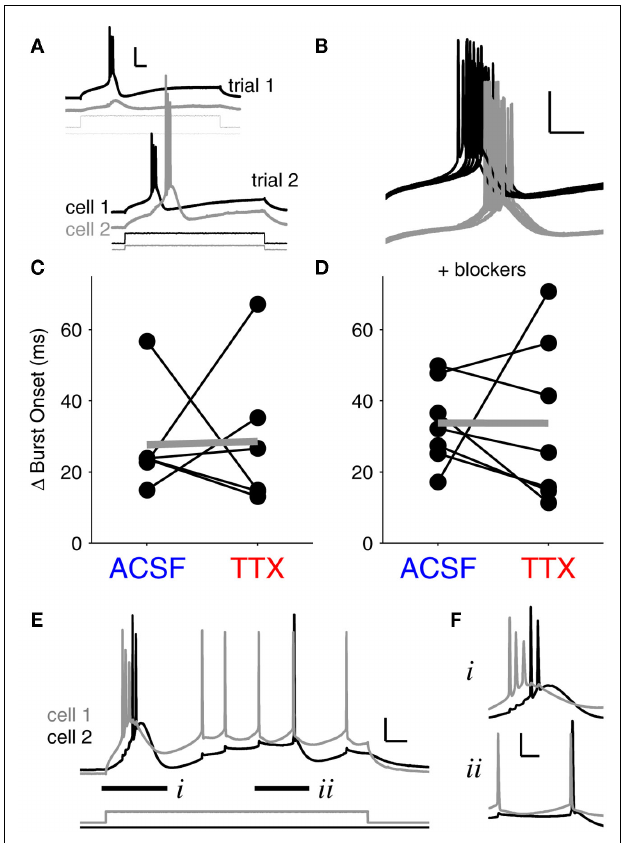
FIGURE 5 | Bursts are unsynchronized events. (A) Demonstration of the stimulation paradigm for paired burst firing. First, current thresholds for bursts were determined independently for each cell (trial 1). Next, bursts were elicited in coupled neurons by delivering peri-threshold current injections to both neurons simultaneously (trial 2).Traces are offset for clarity. Scale bar: 25mV, 50ms. Burst synchrony is taken as the absolute value of the difference in burst onset times between cell 1 and cell 2. (B) Finer time-scale of 15 burst trials in a pair of coupled neurons. Bursts rarely synchronized, and individual burst onsets also varied by tens of ms. Scale bars: 25mV, 50ms. (C) With spontaneous synaptic activity intact, burst synchrony did not show a significant change after blocking I NaP with 100nM TTX. Mean difference in burst onsets in ACSF: 27.6 ± 6.0ms (mean ± SEM, N = 6 pairs); mean difference in burst onsets inTTX: 28.6 ± 8.5ms ( p = 0.94, paired, two-tailed t -test). (D) In the presence of synaptic blockers (DNQX and APV), burst synchrony between coupled cells also showed no significant change afterTTX application. Mean difference in burst onset in ACSF: 33.7 ± 4.5ms ( N = 7 pairs); mean difference in burst onset inTTX: 33.6 ± 8.7ms ( p = 0.99, paired, two-tailed t -test). Differences between values with and without blockers were insignificant ( p > 0.4 for all comparisons, ANOVA). Data points in ( C–F) represent average values for 20–30 trials at burst thresholds for each pair. (E) Gap junction-driven spikes in a strongly coupled pair (mean cc = 0.4) demonstrate the difference between burst and tonic spike synchrony.The burst onset difference (i) was 23ms; the closest two spikes within the bursts were 7.4ms apart.The tonic spikes (ii) were 1.9ms apart. V rest =− 70mV for both cells. Scale bar 15mV, 50ms. (F) Fine resolution of the paired bursts (i) and the paired tonic spikes (ii) , offset for clarity. Scale bar 20mV,